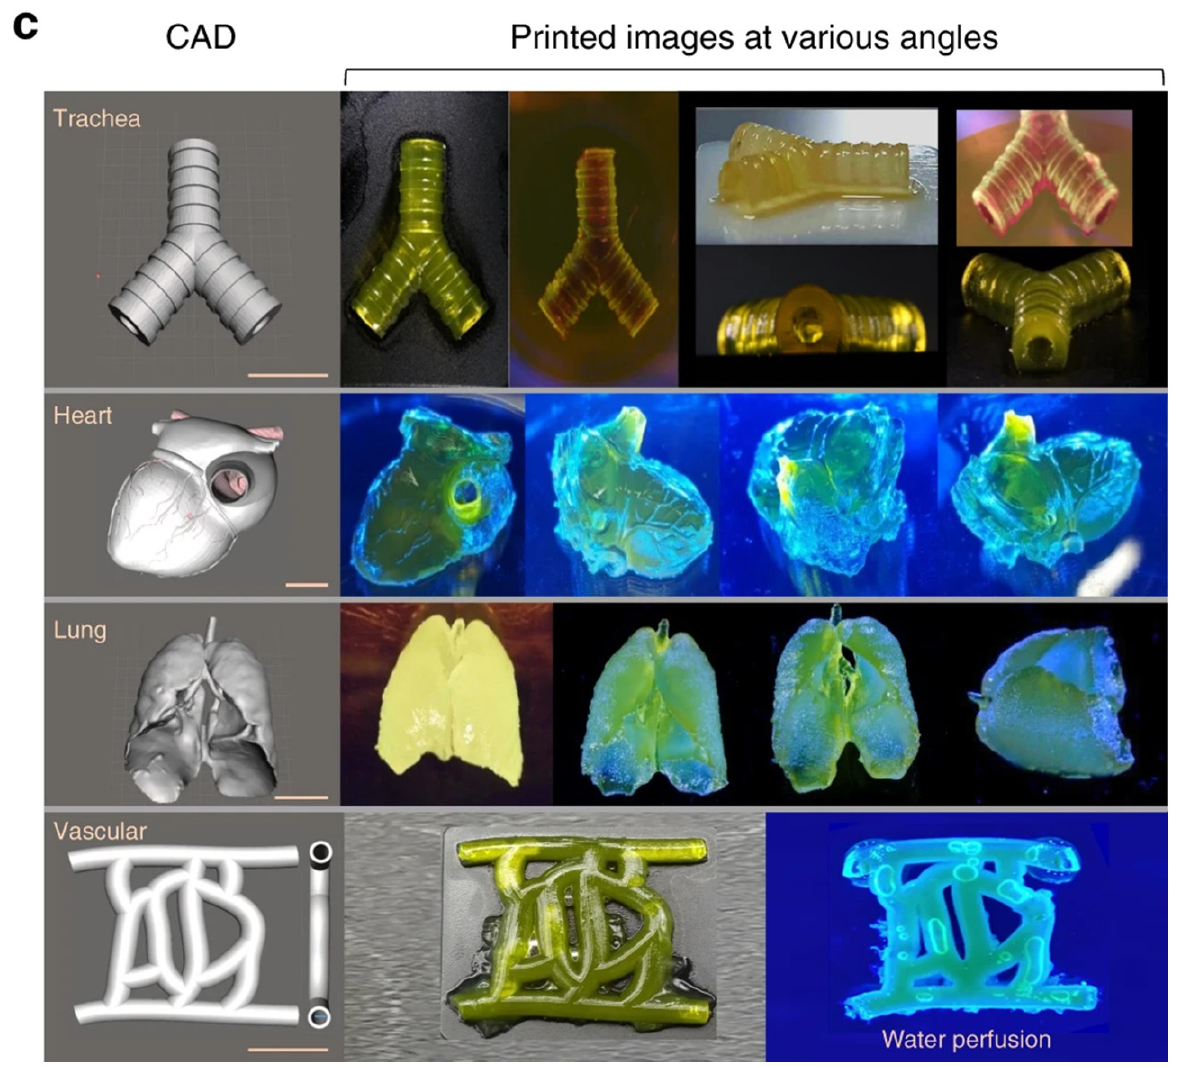
Figure 4. Sil-MA bio-ink’s printability via DLP bioprinter. ( a ) The simulated scaffold and the Eiffel Tower; (l) images of the CAD portraying the scaffolds and Eiffel Tower and (r) printed pictures. ( b ) Human ear and brain mirrored structures; (l) the images of the CAD showing the human ear and brain and (r) printed pictures. Printed constructs were not broken when firmly compacted using fingers, and when fingers were relaxed, they reverted to their primary structures. ( c ) The trachea, heart, lung, and blood vessels imitated morphology; (l) the CAD pictures representing human trachea, heart, lung, and blood vessels and (r) printed pictures at several angles. Printed yields using Sil-MA by DLP displayed complex constructions imitating their CAD pictures, e.g., arteries and veins. Scale bar indicates 1. Adapted from [43] with authorization from Springer